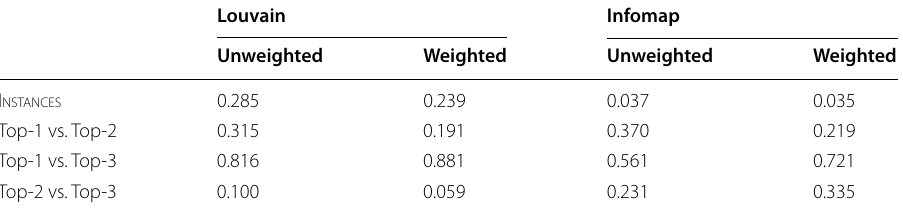
Table 5 Unweighted and weighted conductance scores for the community structures obtained by Louvain and Infomap methods on the I nstancEs network. The first row refers to the average over all pairwise scores between communities, whereas the other rows refer to comparisons between the three largest communities detected by the methods. Weighted variants of conductance account for edges weight when calculating volumes and